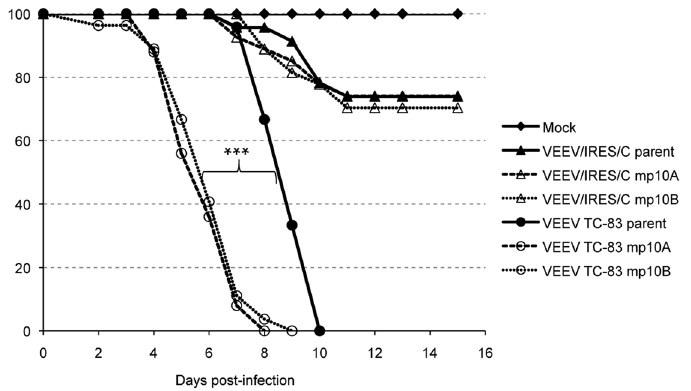
Figure 4. Survival in mice after infection with VEEV/IRES/C or VEEV TC-83 passaged in-vivo . Six-day-old CD1 pups received a 5 6 10 4 PFU dose SC of viruses passaged 10 times in CD1 mice (mp10). Parent unpassaged VEEV TC-83 and VEEV/IRES/C were injected at the same dose as controls. Animals were monitored daily for survival for 14 days. No deaths occurred after day 11 post-infection. ***=P , 0.0001.